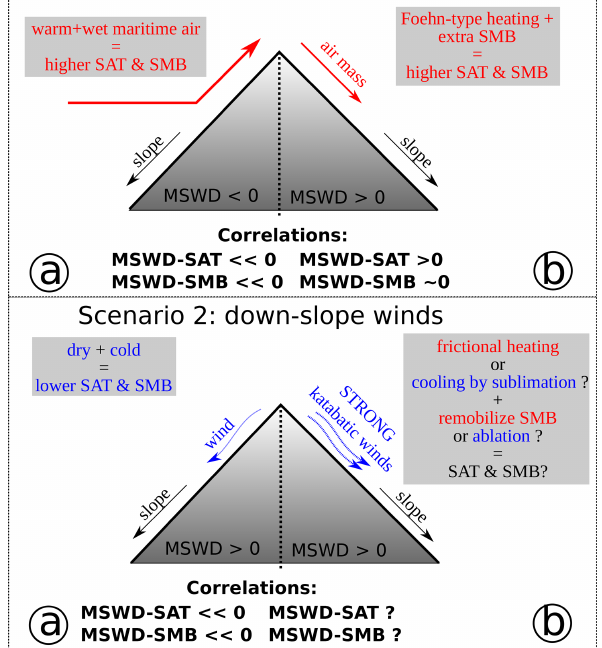
Figure 4. Sketch of slope, wind, MSWD, and the resulting corre- lations expected for the two scenarios described: (1) ocean-sourced warm and moist air interacting with topography and (2) downslope and strong katabatic winds interacting with the